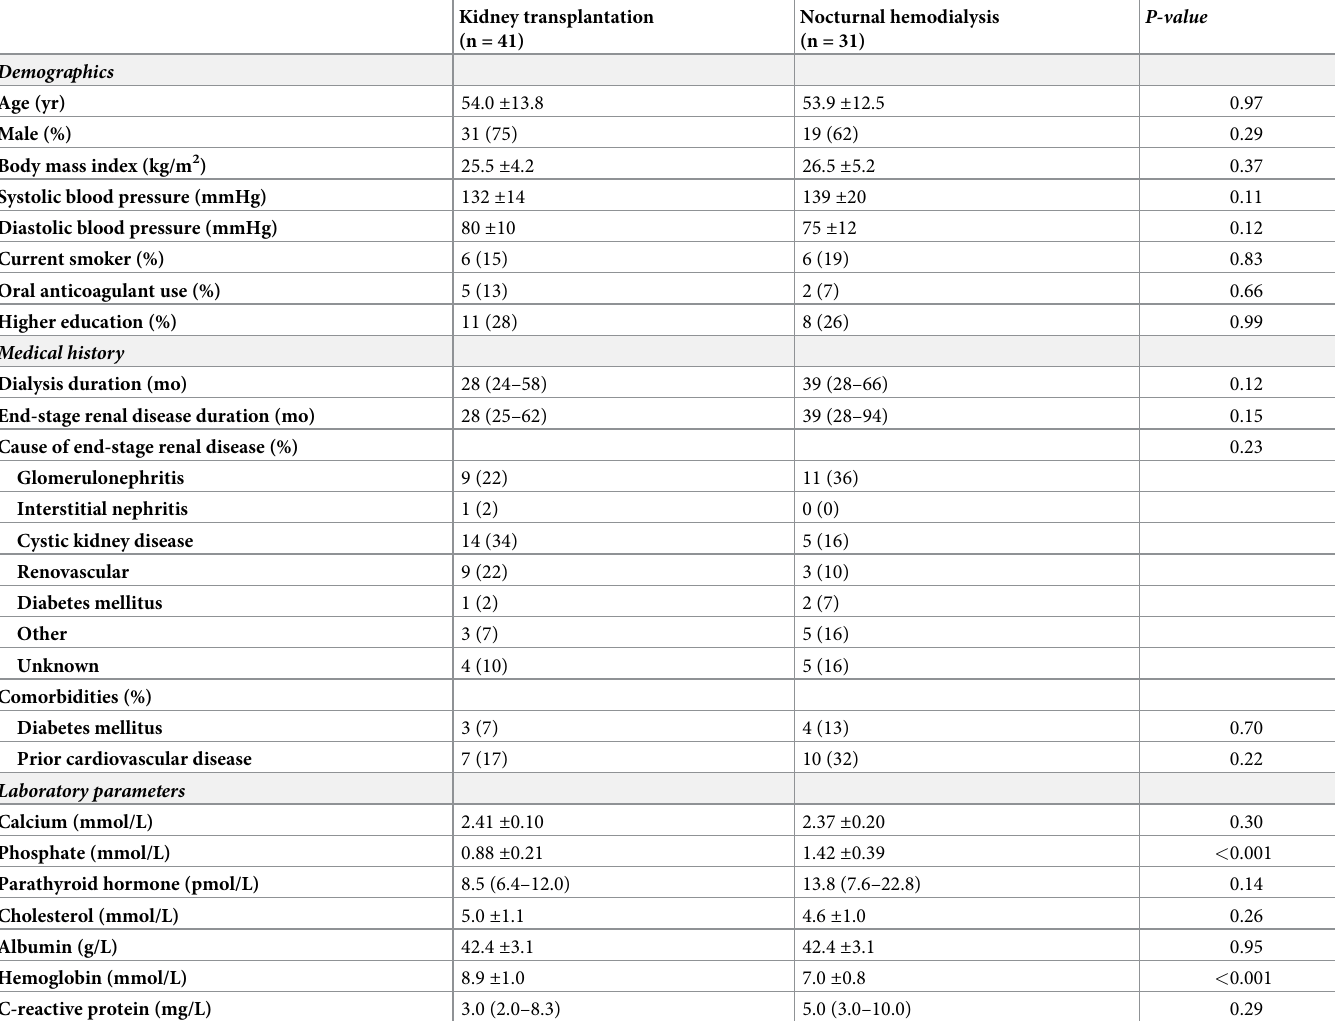
Table 2. Characteristics of the 72 kidney transplant recipients and patients on nocturnal hemodialysis at one year of